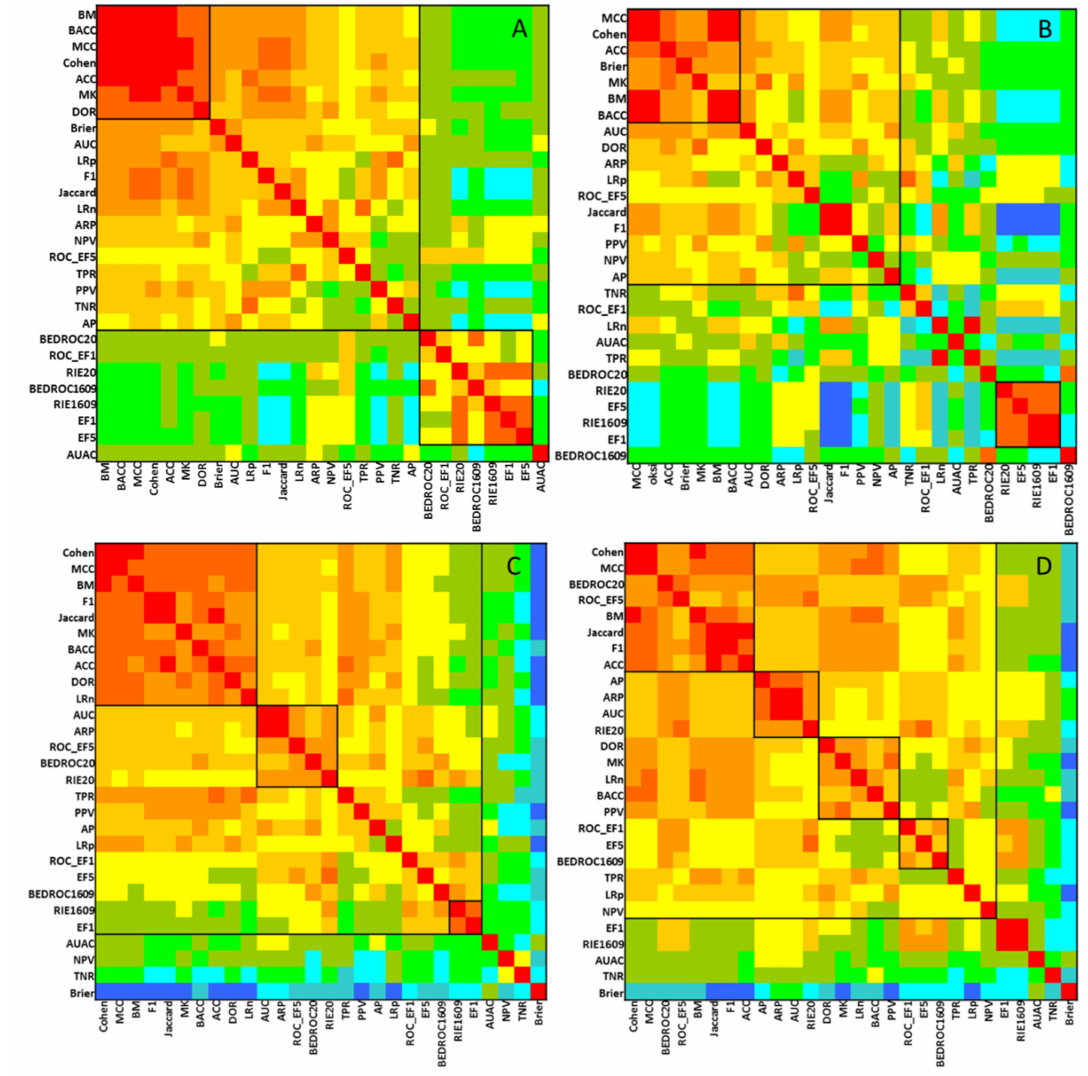
Figure 6. Results of the SRD-COVAT method: 2-class classification with balanced ( A ) and imbalanced ( B ) classes; and multiclass classification with balanced ( C ) and imbalanced ( D ) classes. Clusters of similarly behaving performance parameters are separated with black lines (squares) on the plot based on visual